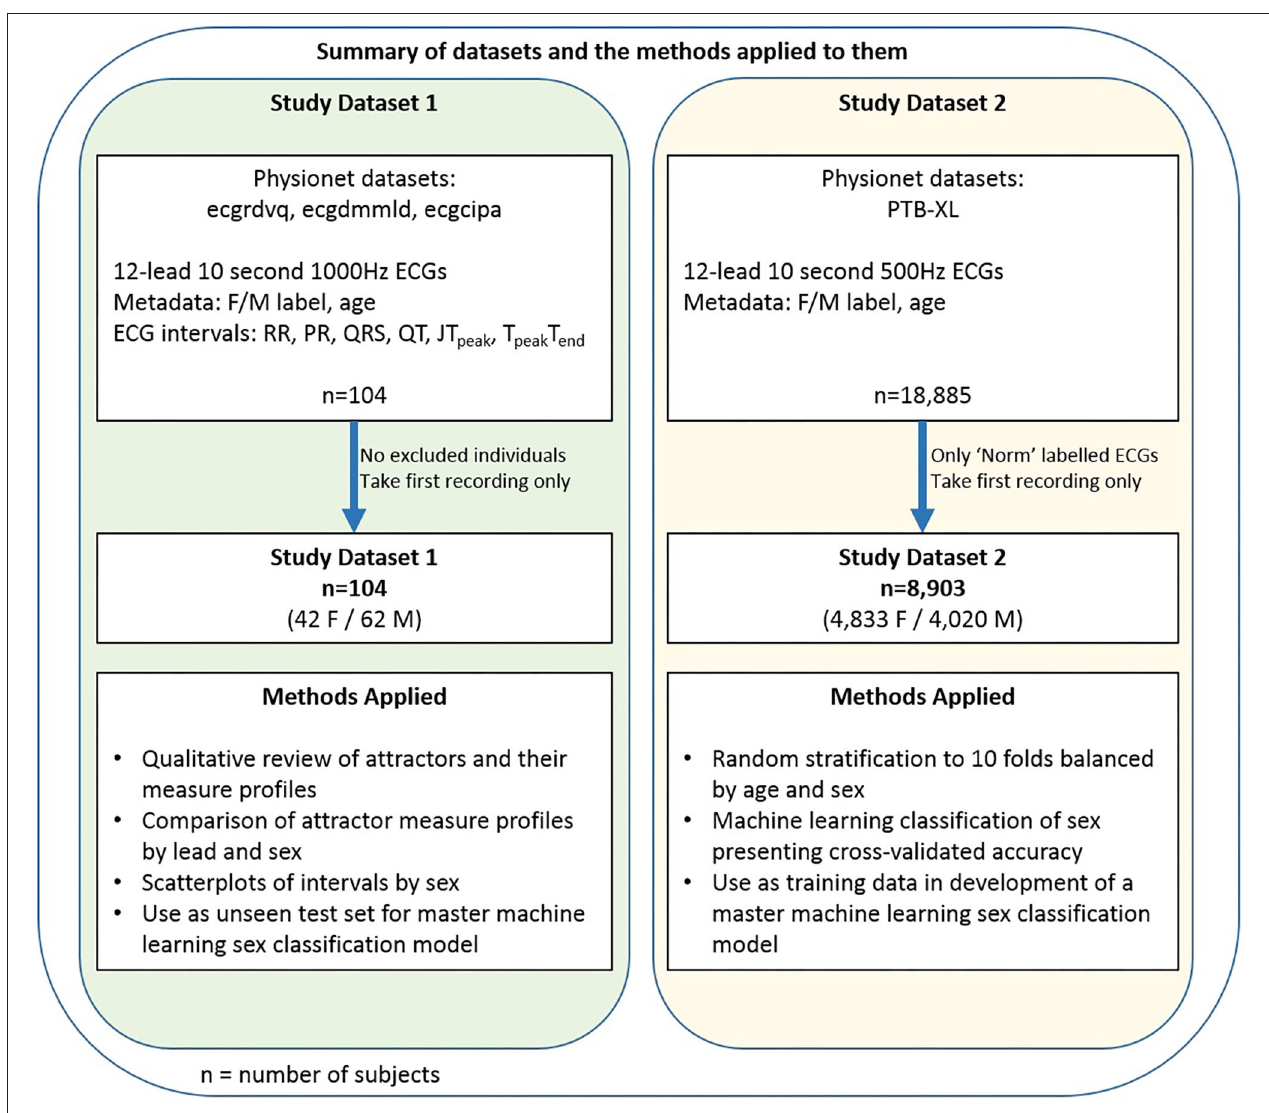
FIGURE 1 | Data and methods summary. A summary of the two datasets and an overview of the methods applied to